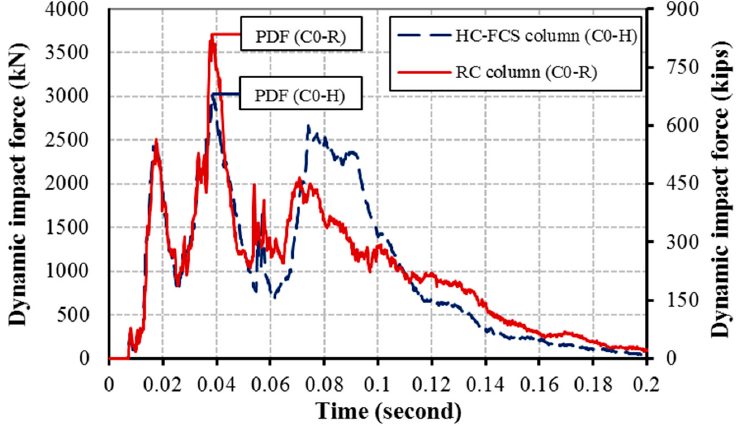
Figure 4. Time-dynamic impact force relationship of C0-R and C0-H columns.